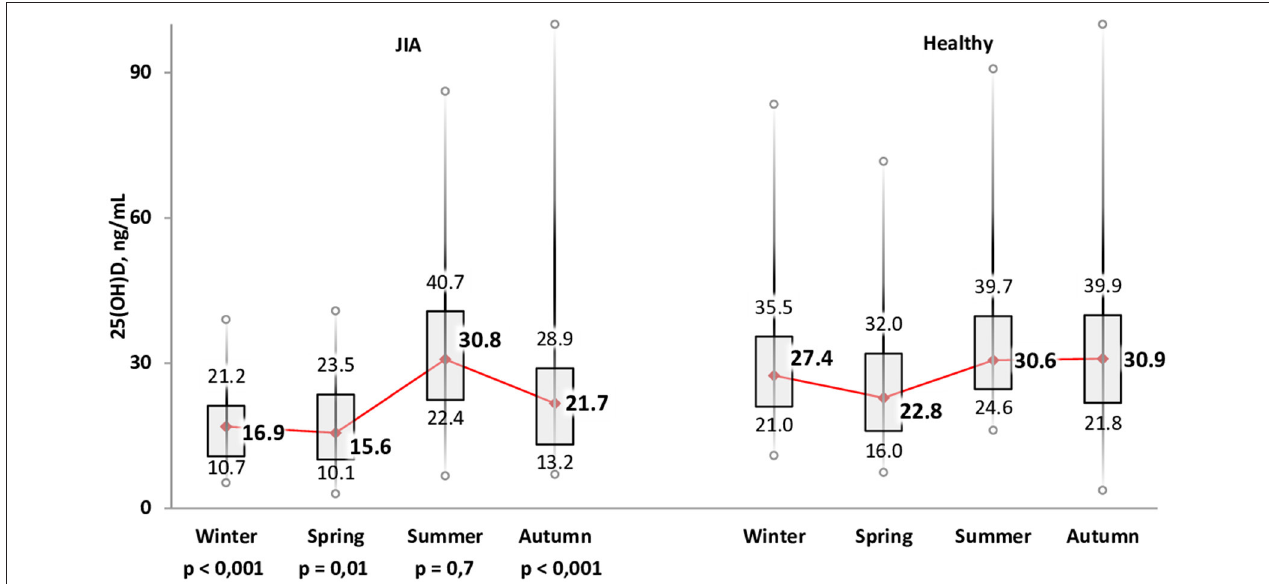
FIGURE 3 | Comparison of the distribution of vitamin D status among the JIA and control groups for each season.